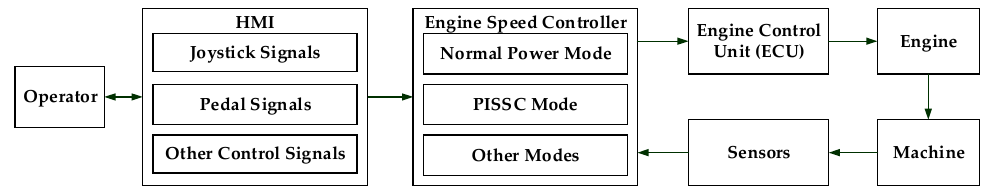
Figure 4. Engine control architecture integrated PISSC approach for a construction machine.